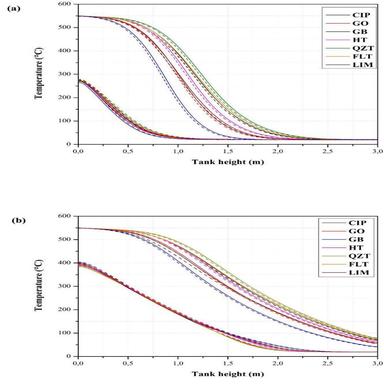
4. Air and rock temperature distributions along the storage tank.(a): Single cycle. (b): Ten consecutive cycles.